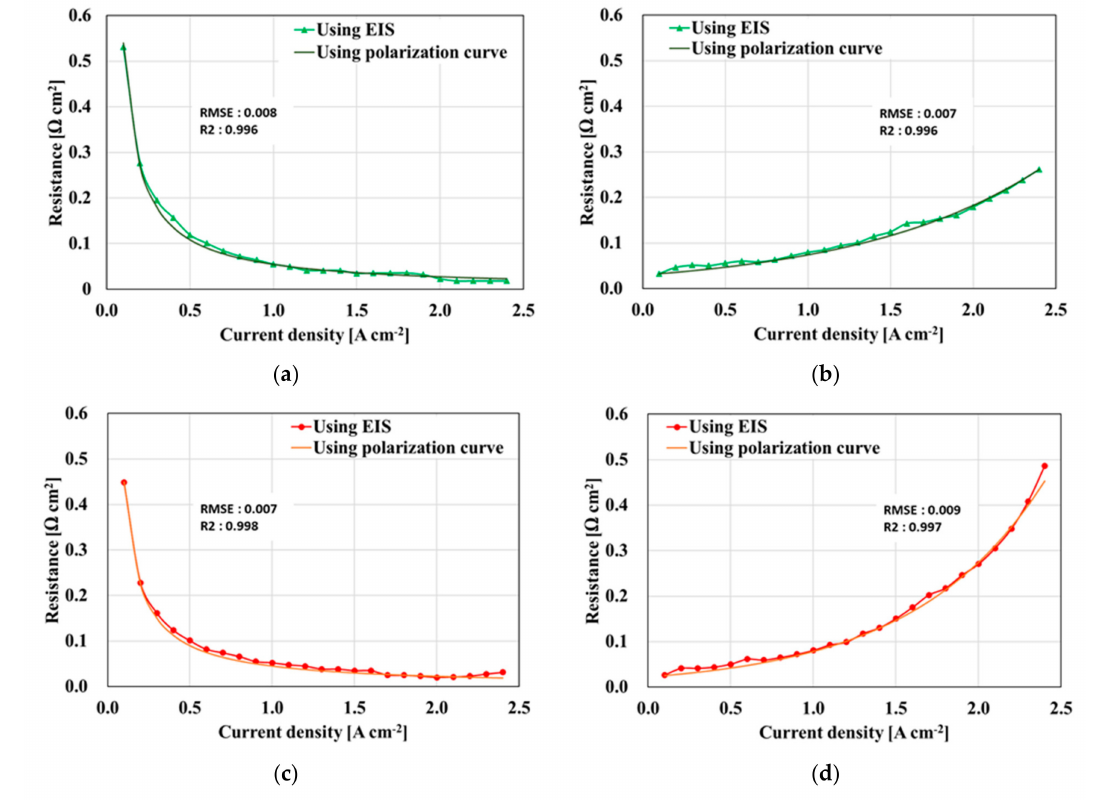
Figure 6. Results of the resistance separation under H 2 /air. ( a ) Charge transfer resistance at RH 80%. ( b ) Mass transport resistance at RH 80%. ( c ) Charge transfer resistance at RH 100%. ( d ) Mass transport resistance at RH